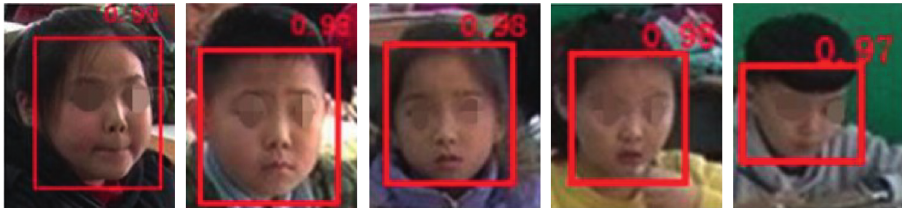
Figure 8: Result of face detector.